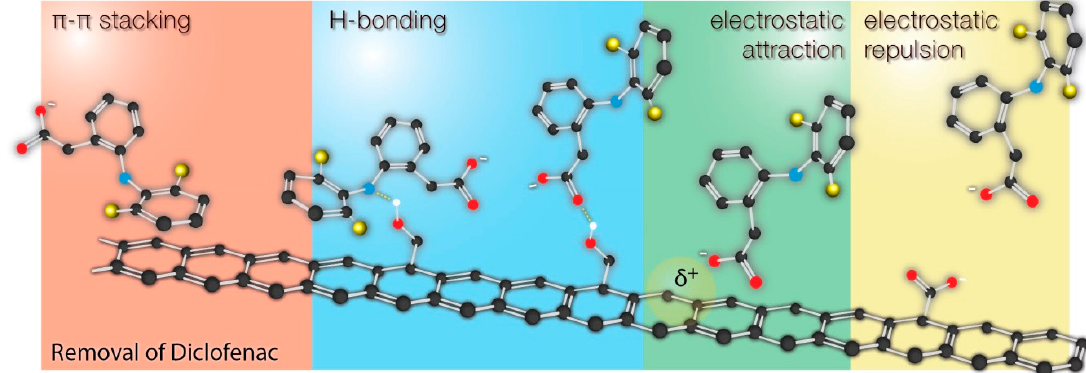
Figure 6. Di ff erent adsorption mechanisms involved in the sorption of diclofenac by carbon-based Figure 6. Different adsorption mechanisms involved in the sorption of diclofenac by carbon ‐ based materials.